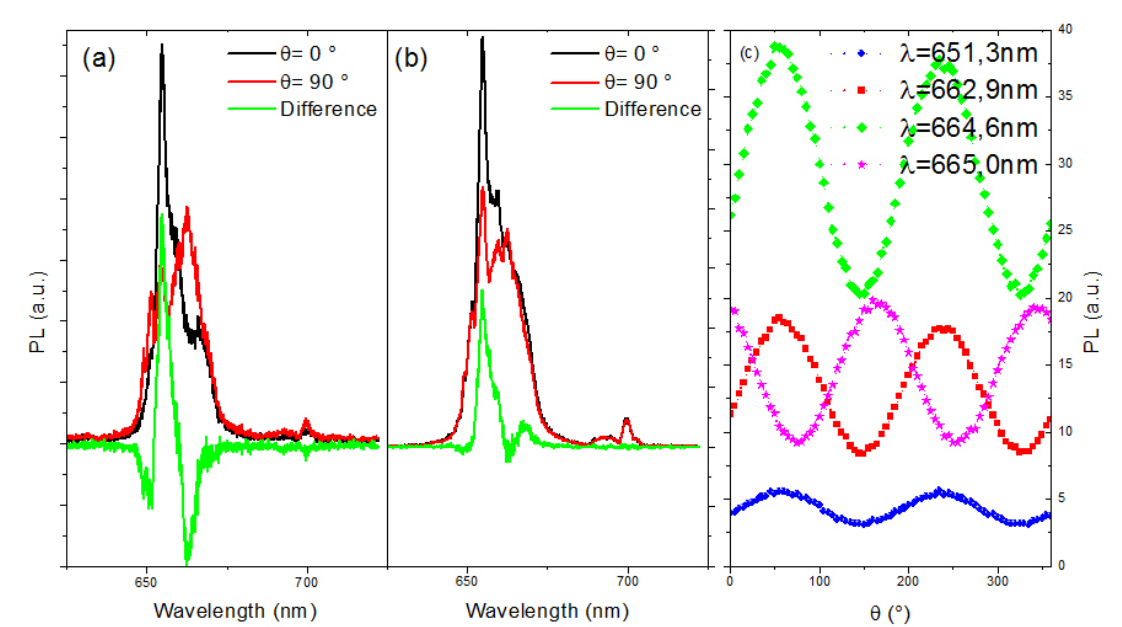
Figure 2. ( a , b ) Spectrum for two orthogonal polarizations (red and black) and the difference between them (green) for two different nanoparticles (NPs) of the same batch NR07. ( c ) PL intensity versus polarization for different wavelengths.